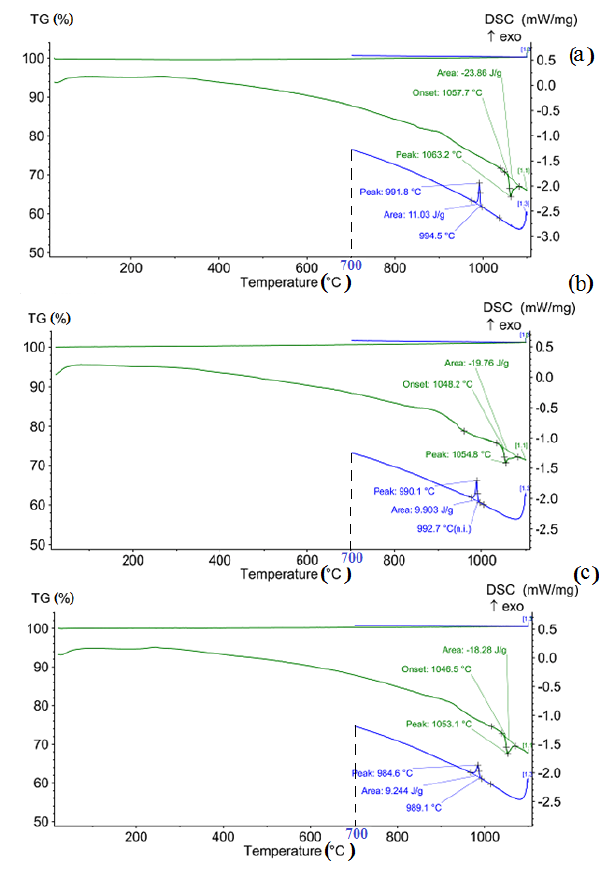
Figure 2: Energy dispersion spectrum of BiNb 0.96 Mn 0.04 O 4− δ of tri- clinic (a) and orthorhombic (b) modifications and photomicrography of its surface in the mode of secondary and elastic backscattered electrons.